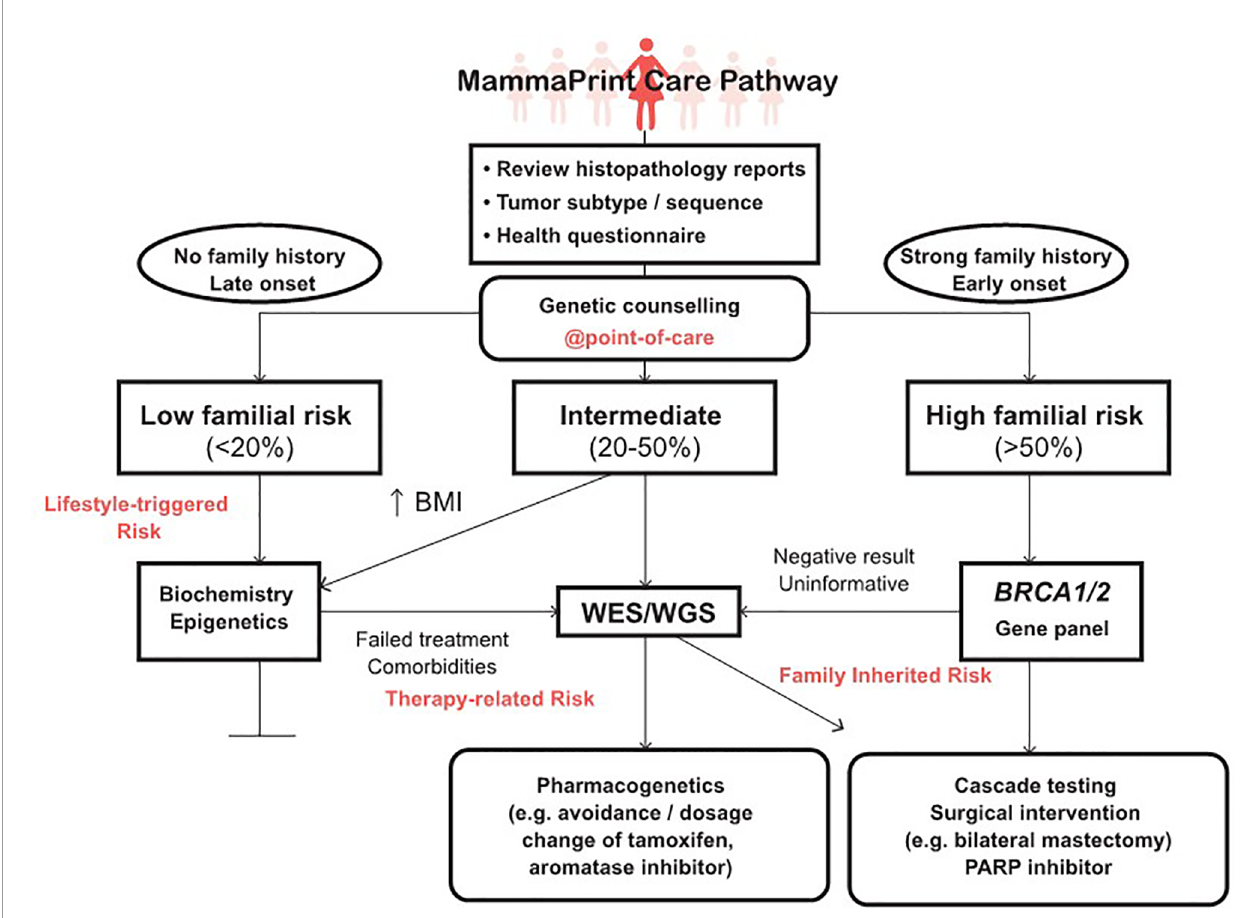
FIGURE 5 | Incorporation of genetic counseling into the MammaPrint care pathway extending from point-of-care germline DNA testing to advanced genomic technologies, including clinical assessments such as body mass index (BMI) and whole exome/genome sequencing (WES/WGS) using a pathology-supported genetic testing